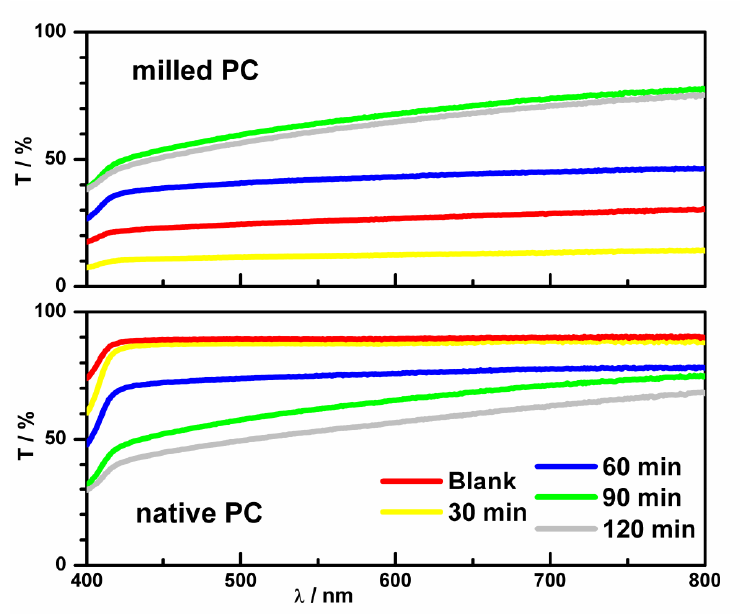
Figure 4. UV-VIS transmission spectra of the milled and native PC plates modified via exposure to 20% solution of NH 4 OH for 2 h at room temperature.